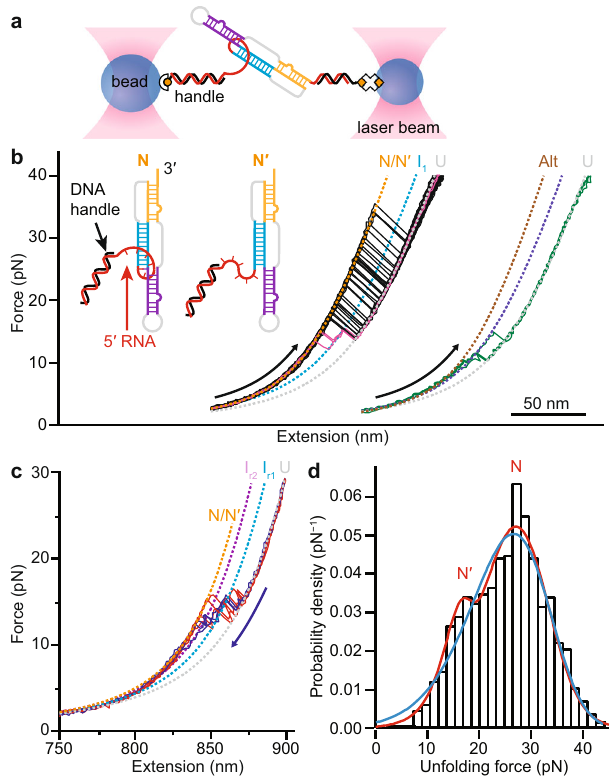
Fig. 2 Force spectroscopy of SARS-CoV-2 pseudoknot. a Schematic of force spectroscopy assay: a single RNA pseudoknot is tethered by duplex handles attached to beads held in optical traps. Pseudoknot secondary structure color-coded as in Fig. 1. b Unfolding force-extension curves (FECs) with 6-nt spacer between handle and pseudoknot (inset: schematic of conformers N and N ′ showing handle location). Black: FECs showing full-length unfolding of pseudoknot without intermediates. Magenta: FECs unfolding pseudoknot via intermediate state I 1 . Green: FECs showing unfolding of alternate stem-loop structures (labeled Alt). Dashed lines: WLC fi ts to each state (orange: N/N ′ , cyan: I 1 , gray: U, brown: Alt; navy: intermediate for Alt). FECs offset for clarity. c FECs showing full-length refolding of pseudoknot, with intermediates corresponding to folding of stem 1 (I r1 , cyan dashed line) and stem 1 + stem 3 (I r2 , purple dashed line). d Unfolding force distribution for pseudoknot ( N = 745 FECs from 10 molecules) shows two peaks, representing the distinct conformers N and N ′ . Blue: fi t to single-population landscape model; red: fi t to two- population